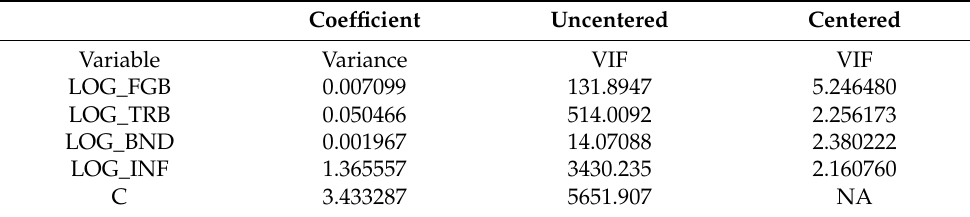
Table 4. Multicollinearity test. Variance Inflation Factors (VIFs). Sample: 2003–2019. Included